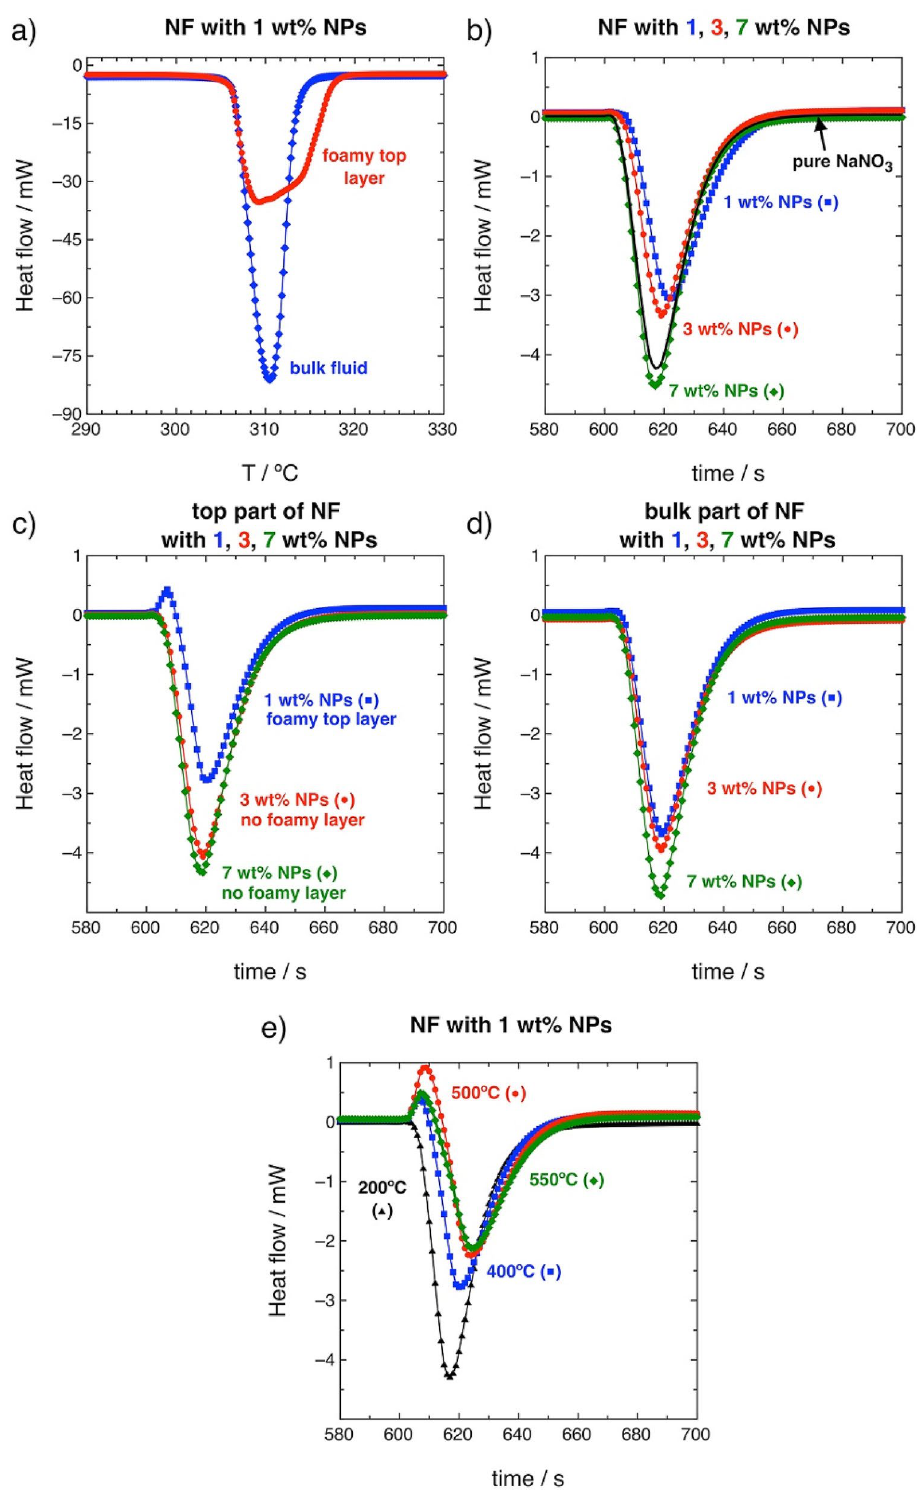
Figure 5. ( a ) Enthalpy of melting of the NF with 1 wt% of NPs: bulk fluid (blue rhombohedras) and foamy top layer (red circles). ( b ) Sensible heat at 400 °C for NFs with 1 wt% (blue squares), 3 wt% (red circles) and 7 wt% (green rhombohedras) of NPs along with the values for pure NaNO 3 (black line). ( c ) Sensible heat at 400 °C of the top part of the NFs with 1 wt% (blue squares), 3 wt% (red circles) and 7 wt% (green rhombohedras) of NPs. The NF with 1 wt% of NPs is the only sample that exhibits the foamy top layer. ( d ) Sensible heat at 400 °C of the bulk fluid part of the NFs with 1 wt% (blue squares), 3 wt% (red circles) and 7 wt% (green rhombohedras) of NPs. ( e ) Temperature evolution of the foamy top layer’s sensible heat from 200 to 550 °C (NF with 1 wt% of